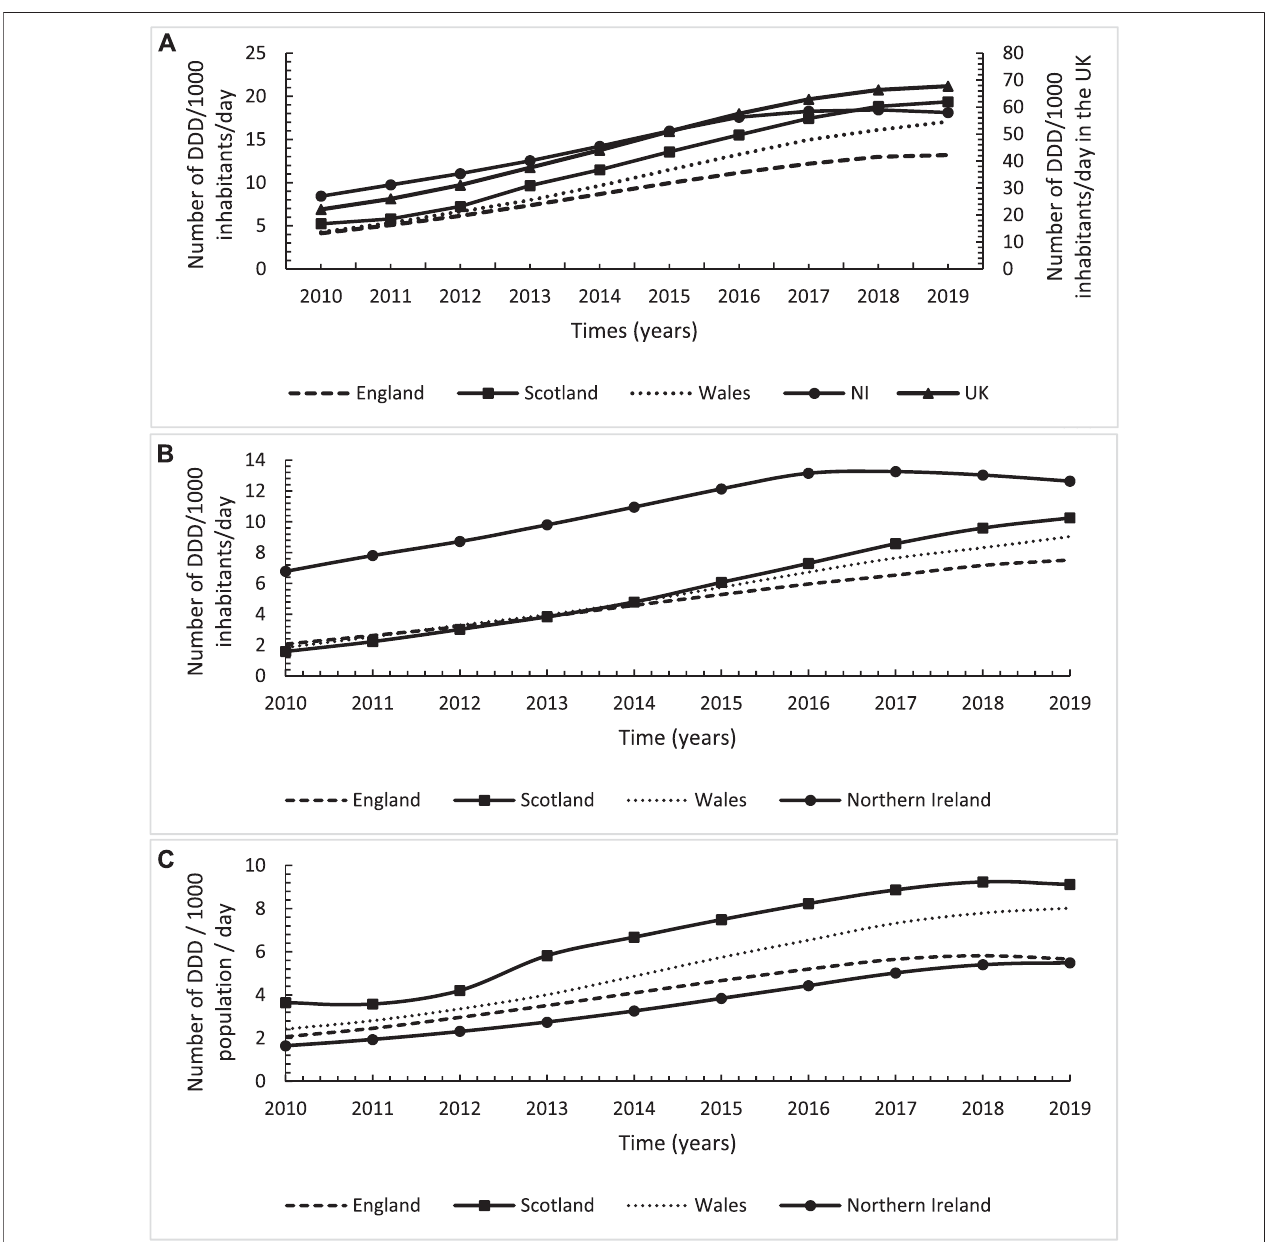
FIGURE 4 | Annual utilisation trends in number of de fi ned daily dose/1,000 inhabitants for gabapentinoids across England, Scotland, Wales and Northern Ireland over the study period from 2010 to 2019; (A) : Total gabapentinoids; (B) : Pregabalin; (C) : Gabapentin.